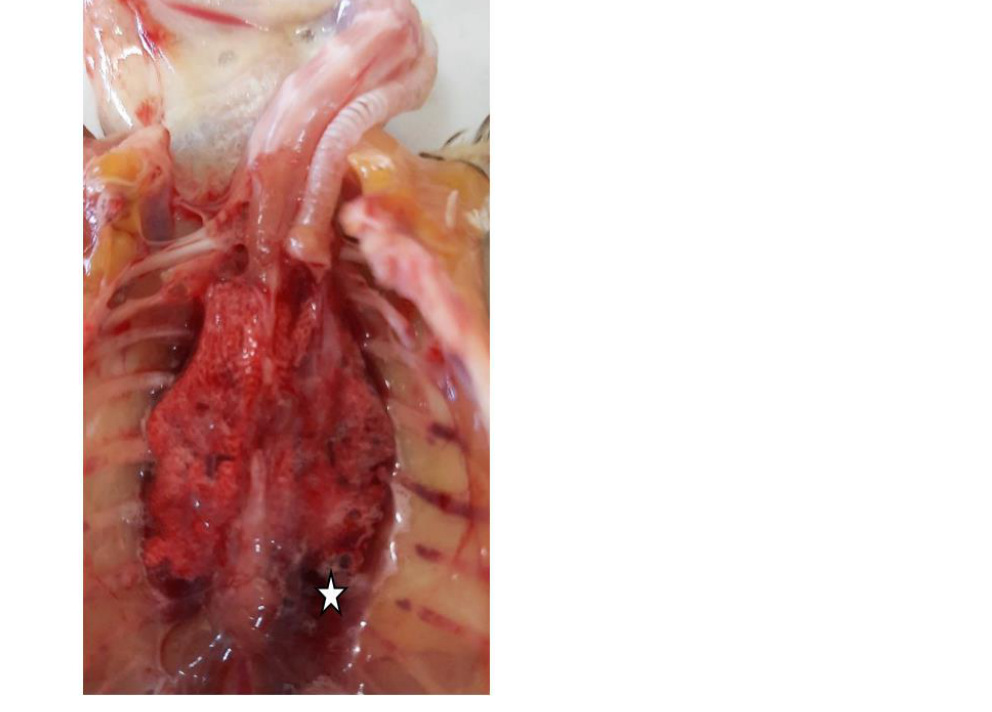
Figure 2. Congestive lungs and pulmonary edema (white star) identified during the necropsy of the Caique.